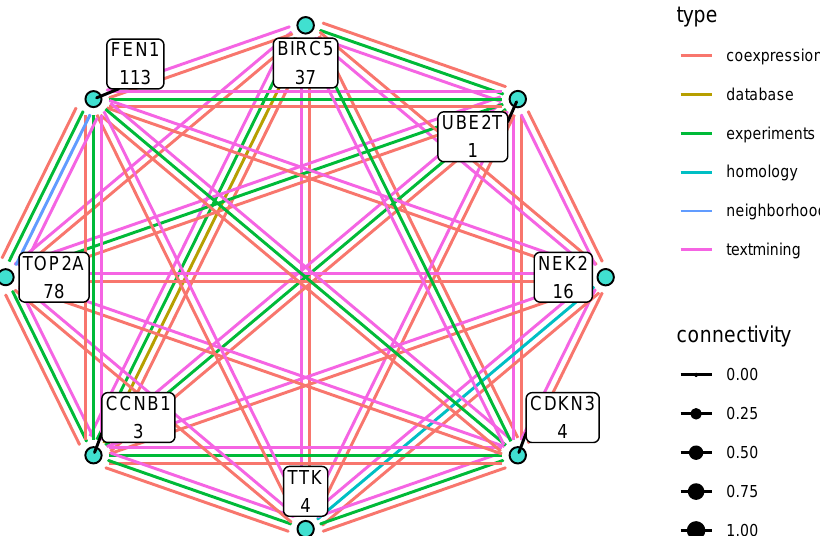
Figure 9. Functional Interaction network underlying the potentially druggable hub genes in module M1. The functional interaction network between potentially druggable hub-genes is shown. Edge color represents interaction type. The number indicates the number of drugs targeting the